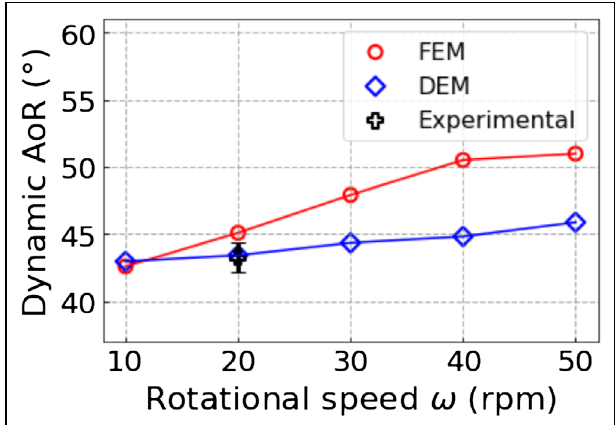
FIGURE 8 | Dynamic angle of repose (AoR) versus the rotational speed from the FEM and DEM model predictions and the experimental